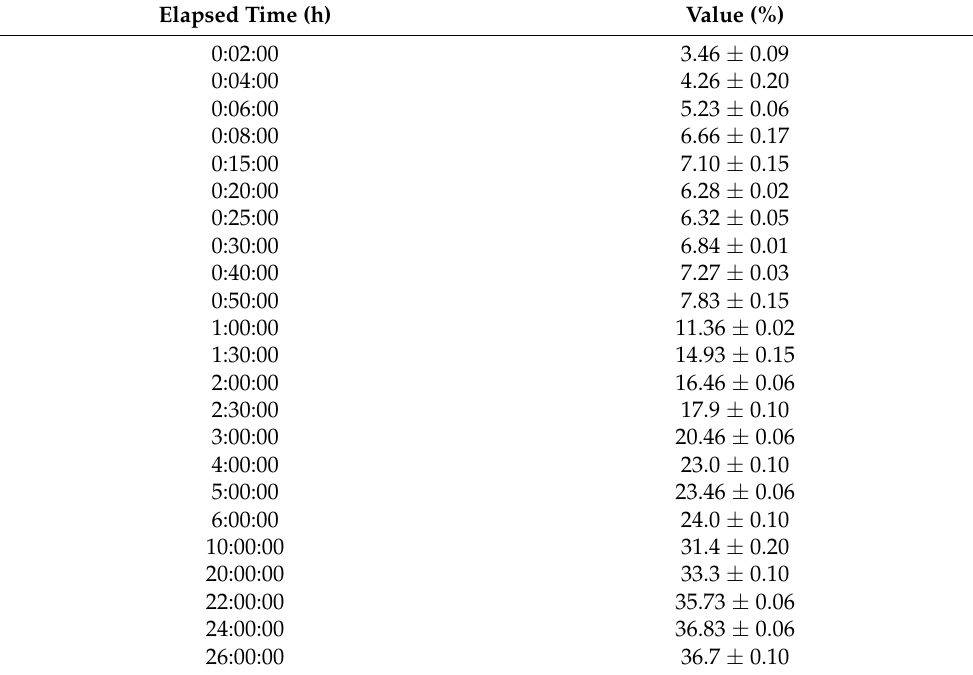
Table A1. Values and standard deviation of Quercetin release from